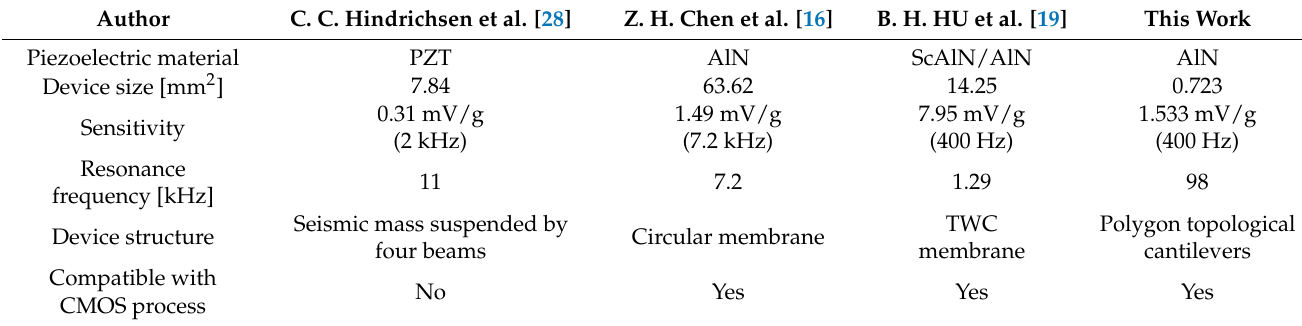
Table 3. Summary of main parameters in piezoelectric